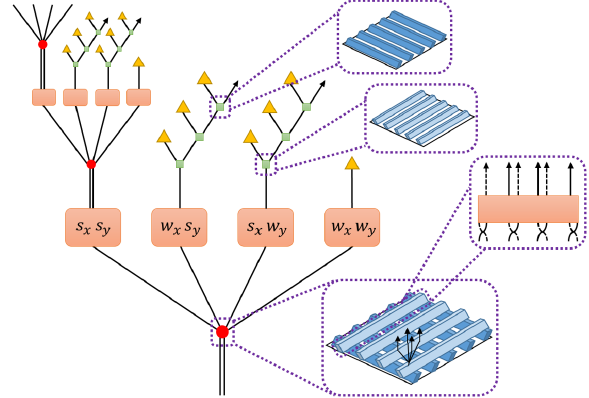
FIG. 5. Branching MERA quantum circuit preparing an approximate ground state of the two-dimensional hopping Hamiltonian (7). The bottom layer consists of applying one- dimensional wavelet transforms in both the x and y directions of the 45-degree rotated lattice. This gives rise to four outputs, as illustrated in detail in Fig. 6. The wavelet-wavelet output corresponds to approximate eigenstates and hence can be projected out after a subsequent Hadamard transform that couples the even and the odd sublattice, indicated by yellow triangles. The mixed wavelet-scaling outputs are disentangled in one direction and therefore have to be processed further by one-dimensional transformations in the scaling directions, giving rise to two branches that take the form of binary trees as in Fig. 1. The scaling-scaling output contains no disentangled d.o.f. and is thus connected to a copy of the circuit on the renormalized lattice.